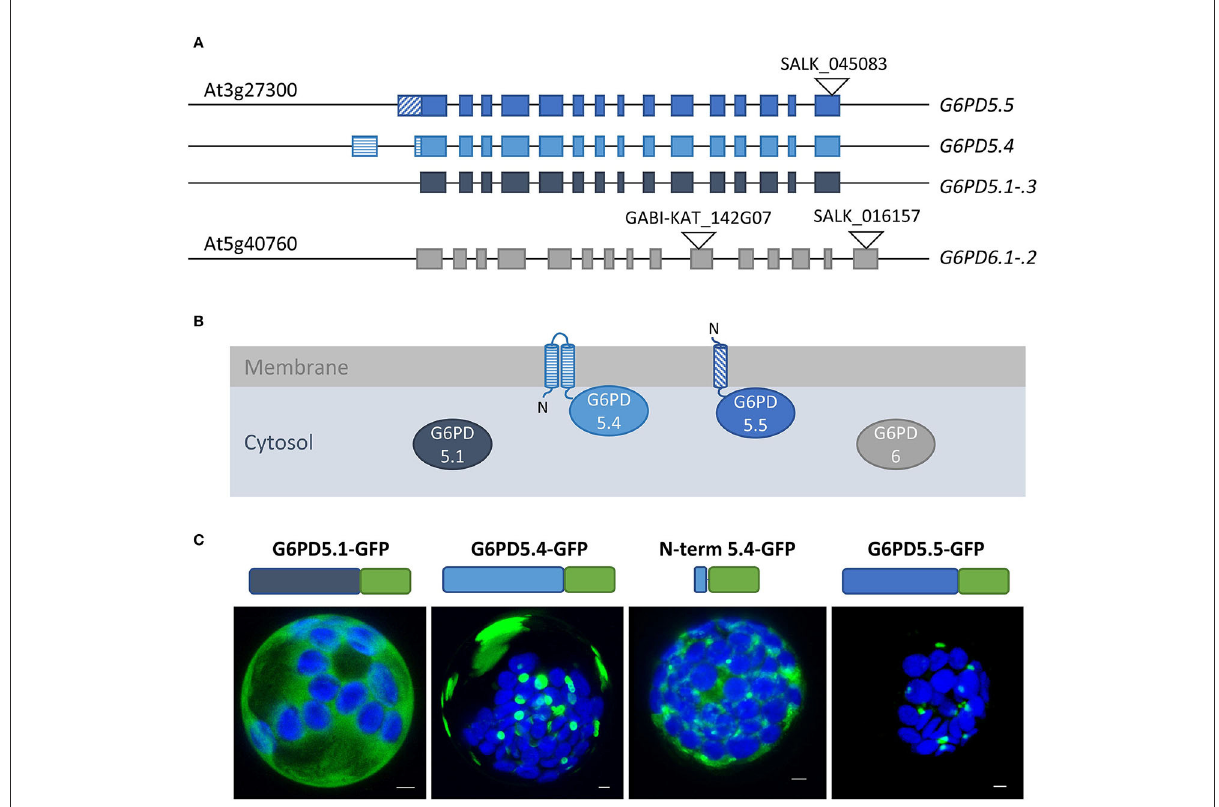
FIGURE2 Alternative splice variants of G6PD5 encode N-terminally extended proteoforms. (A) To-scale depiction of the splice variants that may be generated from the cytosolic G6PD loci, five from G6PD5 (At3g27300) and two from G6PD6 (At5g40760). Compared to splice variants G6PD5.1 through .3 (and G6PD6.1-.2 ) G6PD5.4 and .5 code for N-terminally extended proteoforms. Exons are shown as boxes with alternative 5 ′ parts in different patterns. T-DNA insertion positions in the indicated mutant lines are depicted as black triangles (GABI-KAT_142G07 was used